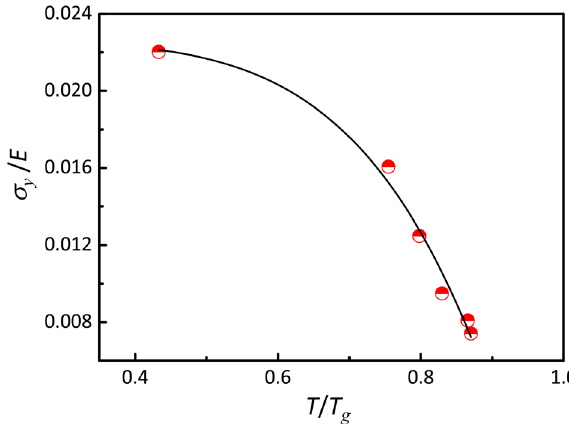
Fig. 6 The relation of specimen temperature T vs. yield strength σ y for the Zr 55 Cu 30 Al 10 Ni 5 (Zr55) bulk metallic glass (BMG). The data are fi tted to the power law: σ y ~( T / T g ) n , suggesting n ∼ 5.2. E is the Young ’ s